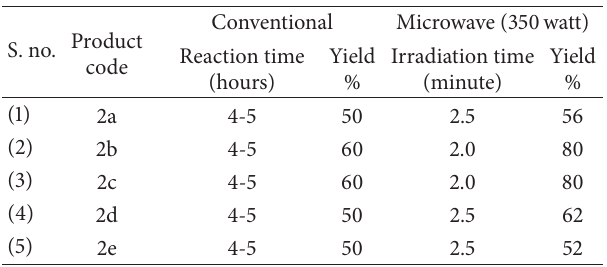
Table 1: Comparative statement of synthesis under conventional and microwave